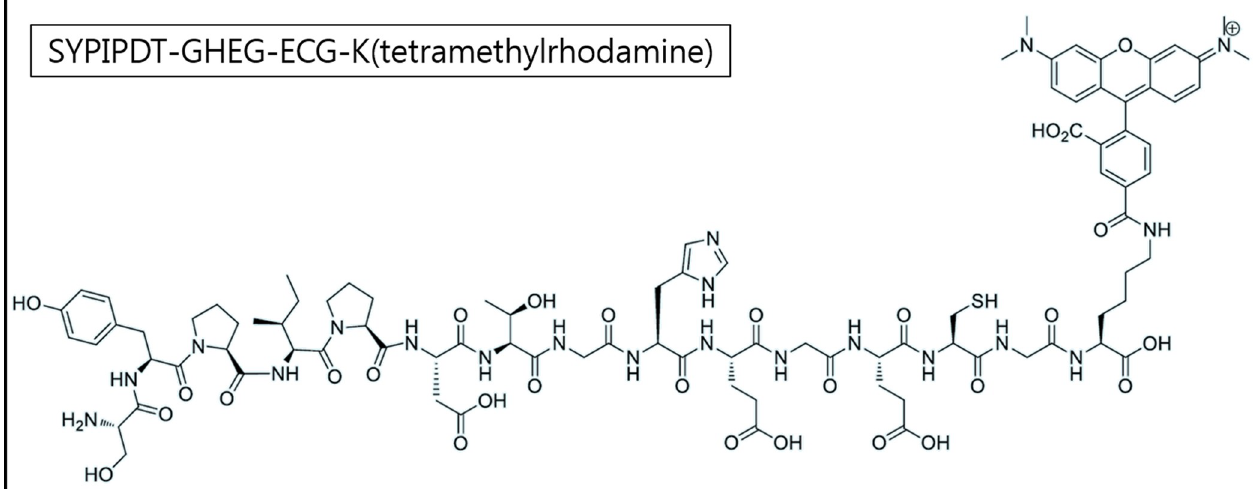
Fig 1. Chemical structure of SYPIPDT-GHEG-ECG-K-tetramethylrhodamine (SYPIPDT-ECG-TAMRA).